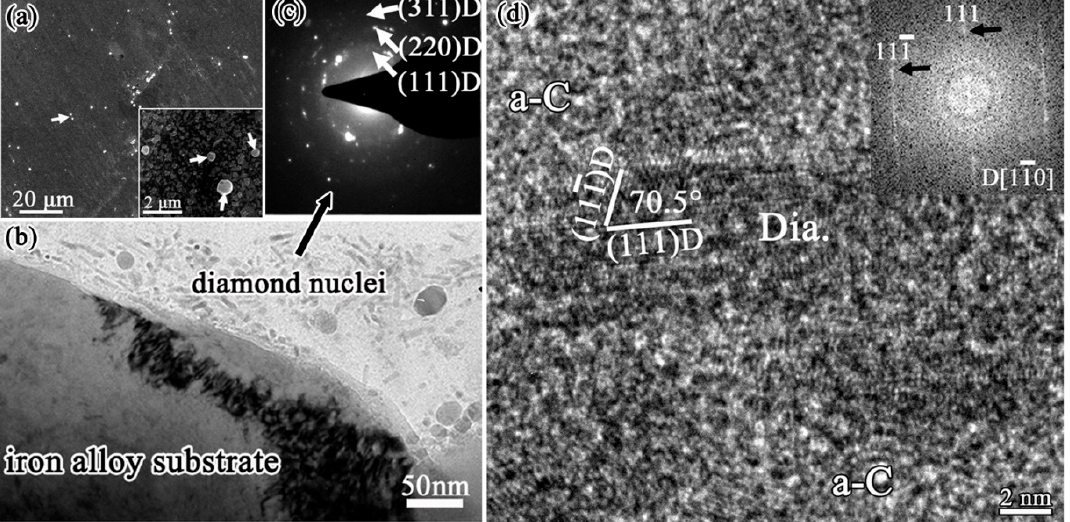
Figure 10. Diamond deposited on Fe-Cr-Al substrate at the very early stage: ( a ) SEM image, with the inset showing the magnified view, showing only some small diamond particles disperse on the substrate surface; ( b ) cross-sectional TEM image shows one surfacial grooves on Fe-Cr-Al substrate, with some diamond nuclei were found; ( c ) the corresponding SAED pattern of these diamond nuclei; ( d ) HRTEM image of one of these diamond nuclei, with the inset showing the corresponding FFT. (Reproduced with permission from [90]).